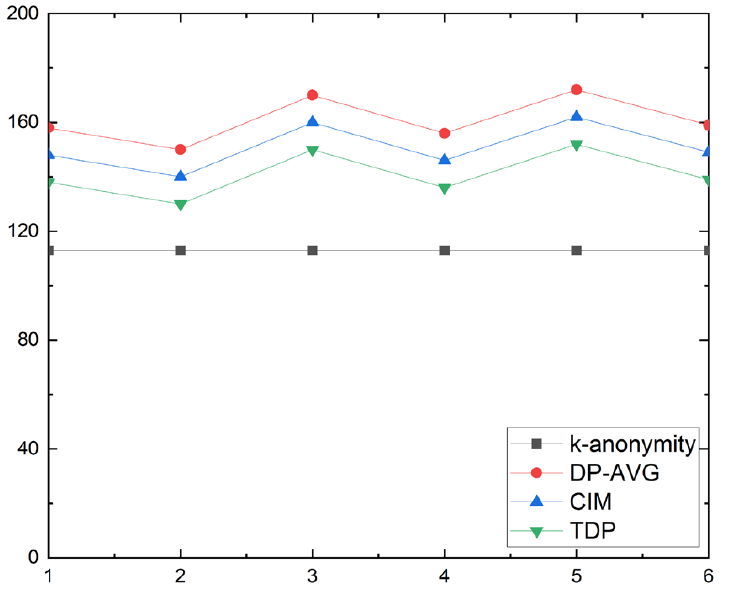
Figure 11. MSE comparison diagram for T-drive Taxi Trajectories dataset (using k -anonymity and TDP